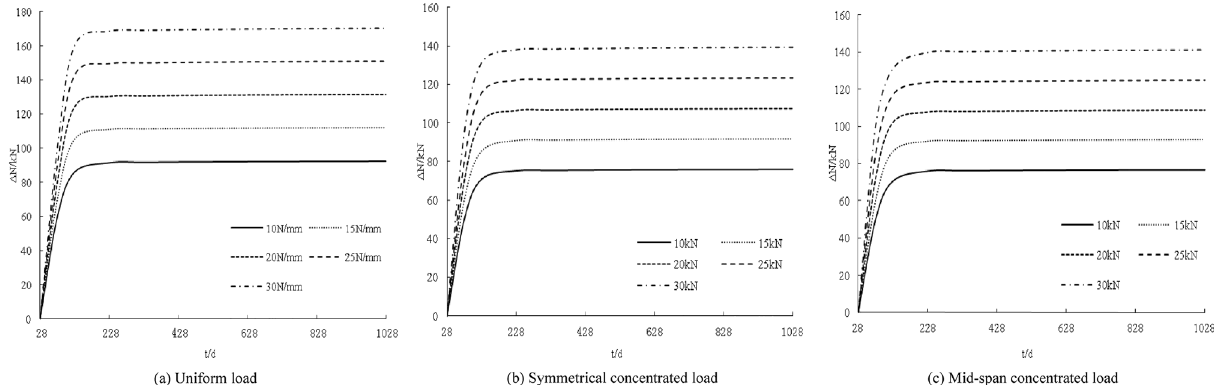
Figure 4. Influence of loading under creep on axial force increment.